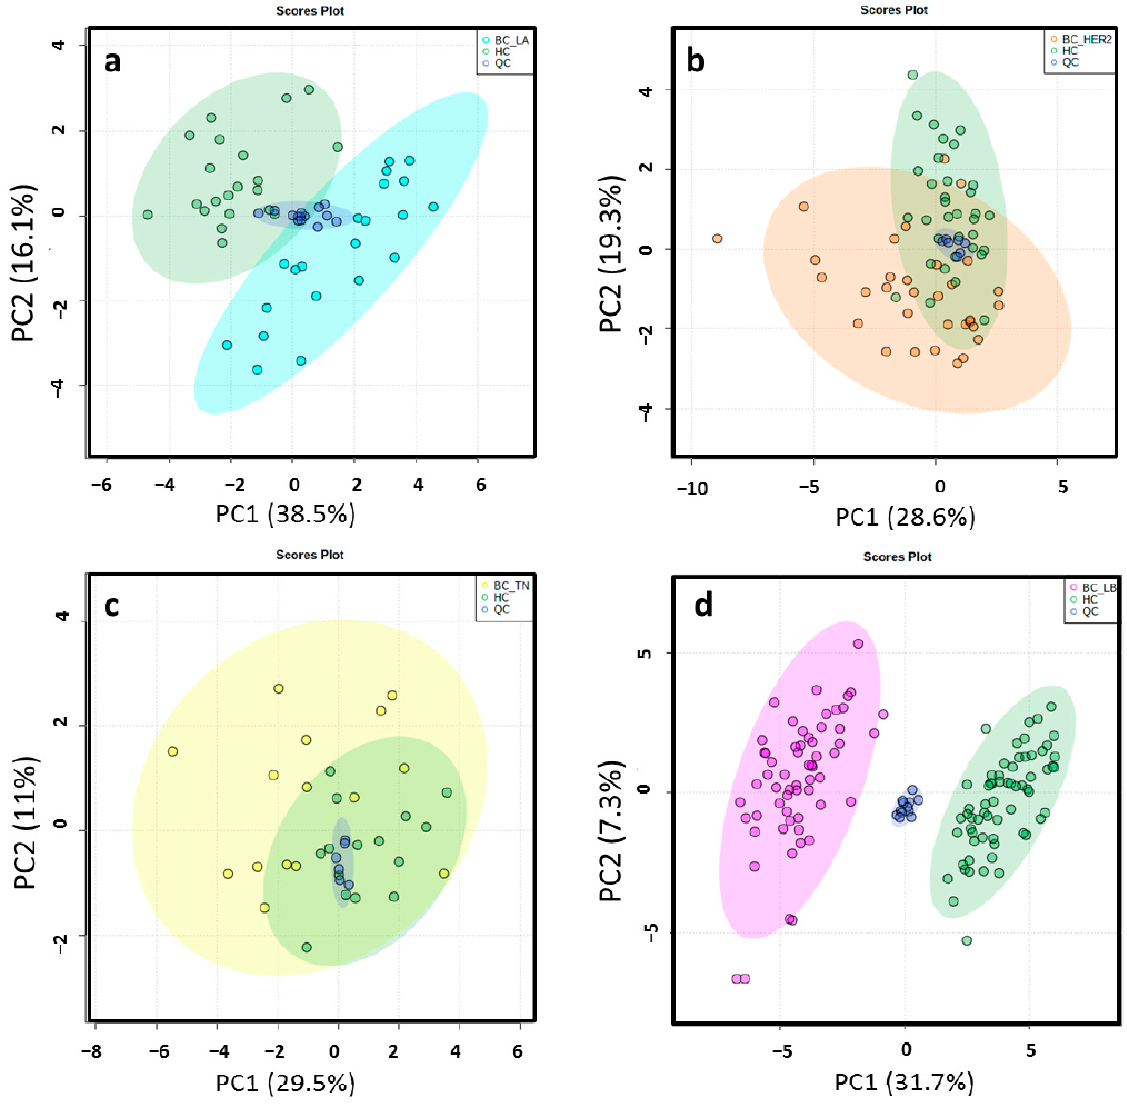
Figure 2. 2D score plots of the unsupervised PCA of HC group (green) and LA_BC (light blue) ( a ), HER2_BC (orange) ( b ), TN_BC (yellow) ( c ) and LB_BC (pink) ( d ) patients by ESI − showed that the separation observed between the groups was due to biological reasons according to the close clustering of the QC samples (dark blue).